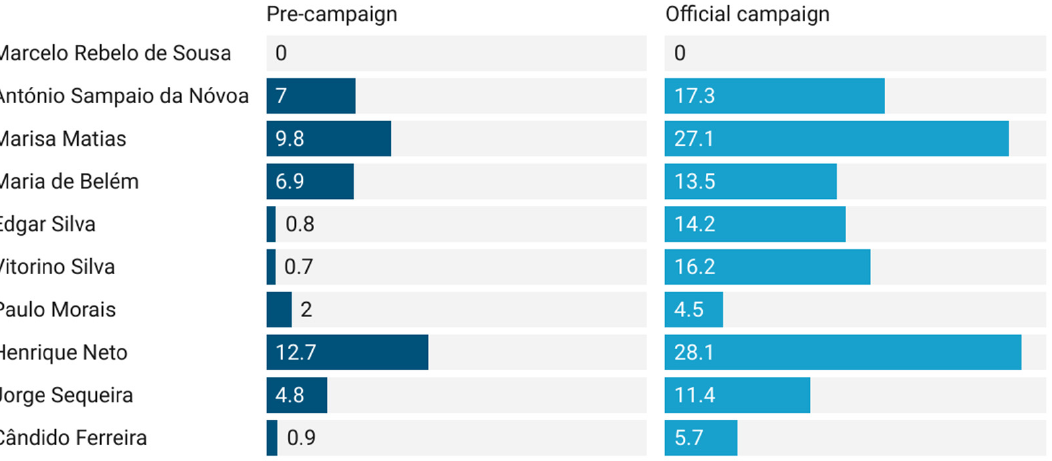
Figure A4. Online campaigning before and after the beginning of the official election campaign in 2016 (average engagement per content on social media). Source: Own data (see Section 3.1.2). Table A1. Planned investment and actual expenses in the 2021 Presidential election campaigns. Professionalization